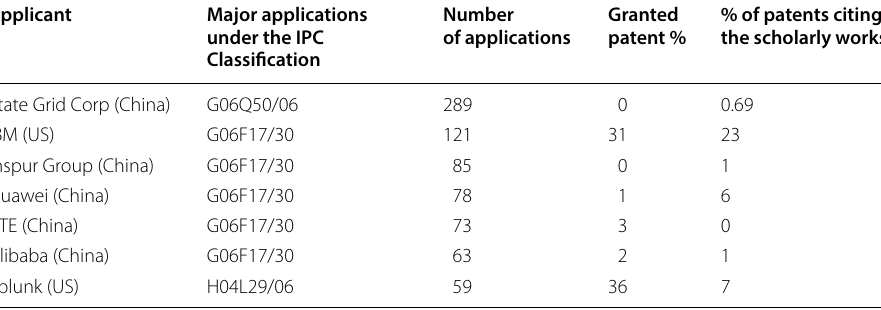
Table 2 The most productive big data applicants; and their linkage with scholarly